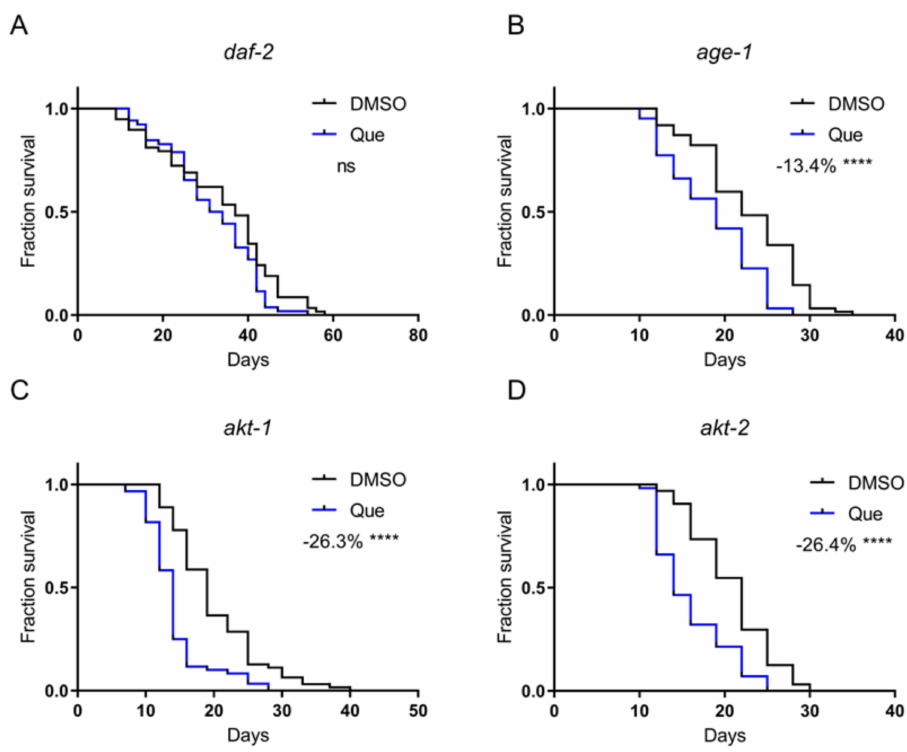
Figure 3. Quetiapine shortens lifespan through DAF-2, but not the downstream Akt pathway. Survival curves of mutant daf-2 ( n = 60 worms per group) ( A ), age-1 ( n = 60 worms per group) ( B ), akt-1 ( n = 60 worms per group) ( C ), and akt-2 ( n = 60 worms per group) ( D ) treated with 100 µ M of quetiapine or DMSO at 20 ◦ C. Data were analyzed by using log-rank test (ns: no significant difference with p > 0.05; ****: p < 0.0001). Experiments were performed in at least two independent biological replicates.